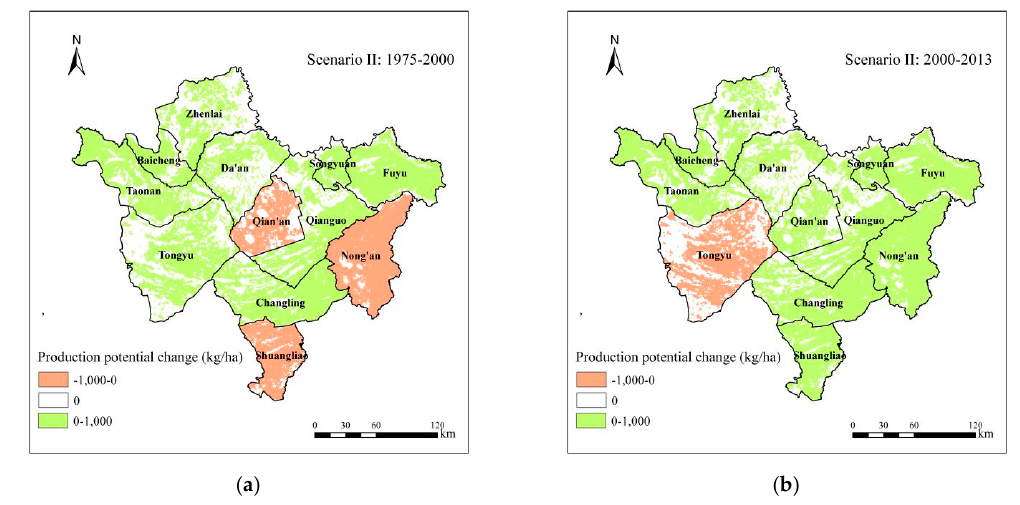
Figure 10. Spatial distribution of soybean production potential change between 1975 and 2000, and between 2000 and 2013 under Scenario II. ( a ) between 1975 and 2000; ( b ) between 2000 and 2013.